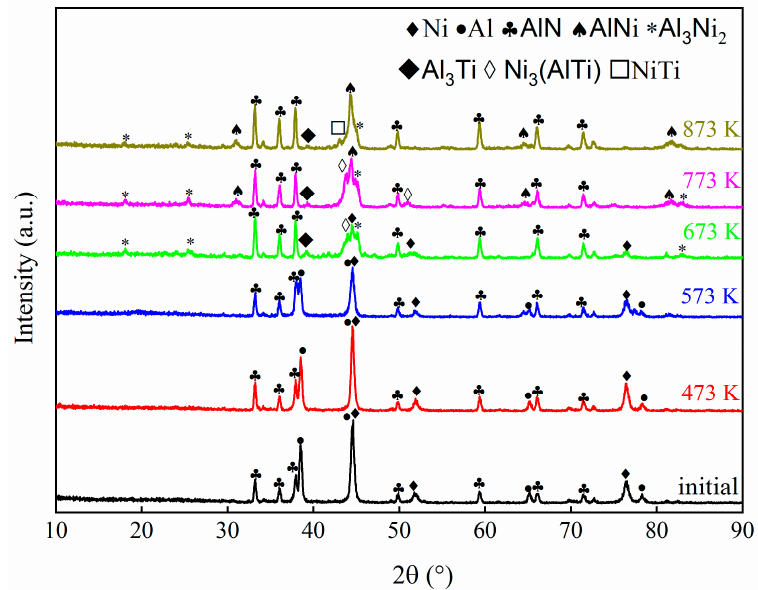
Figure 1. The grazing incidence XRD patterns of the as ‐ deposited ATNT multilayer foil and those foils after annealing at 473 K, 573 K, 673 K, 773, and 873 K for 3 h. foils after annealing at 473 K, 573 K, 673 K, 773, and 873 K for 3